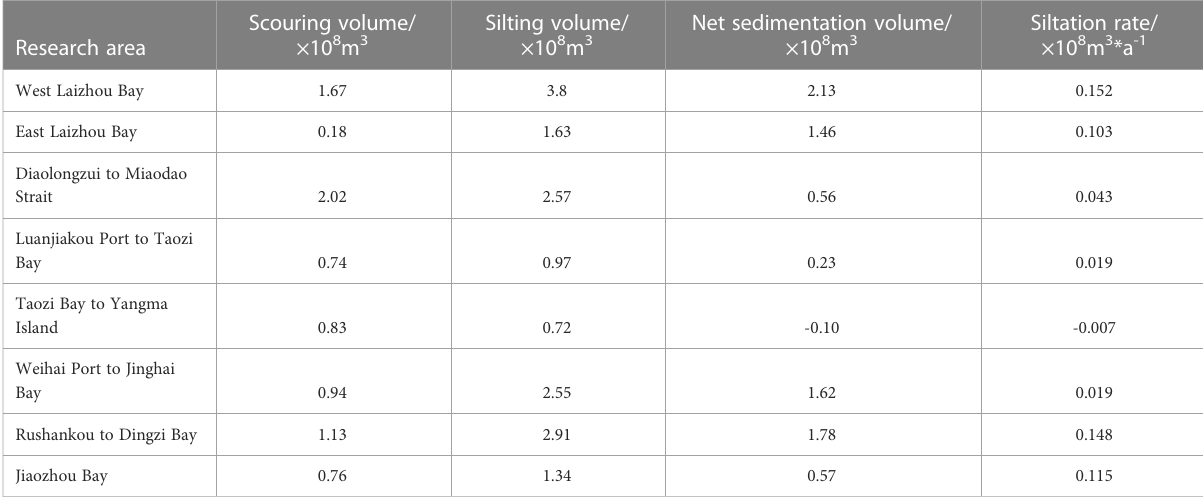
TABLE 1 State of erosion/accretion in typical inshore